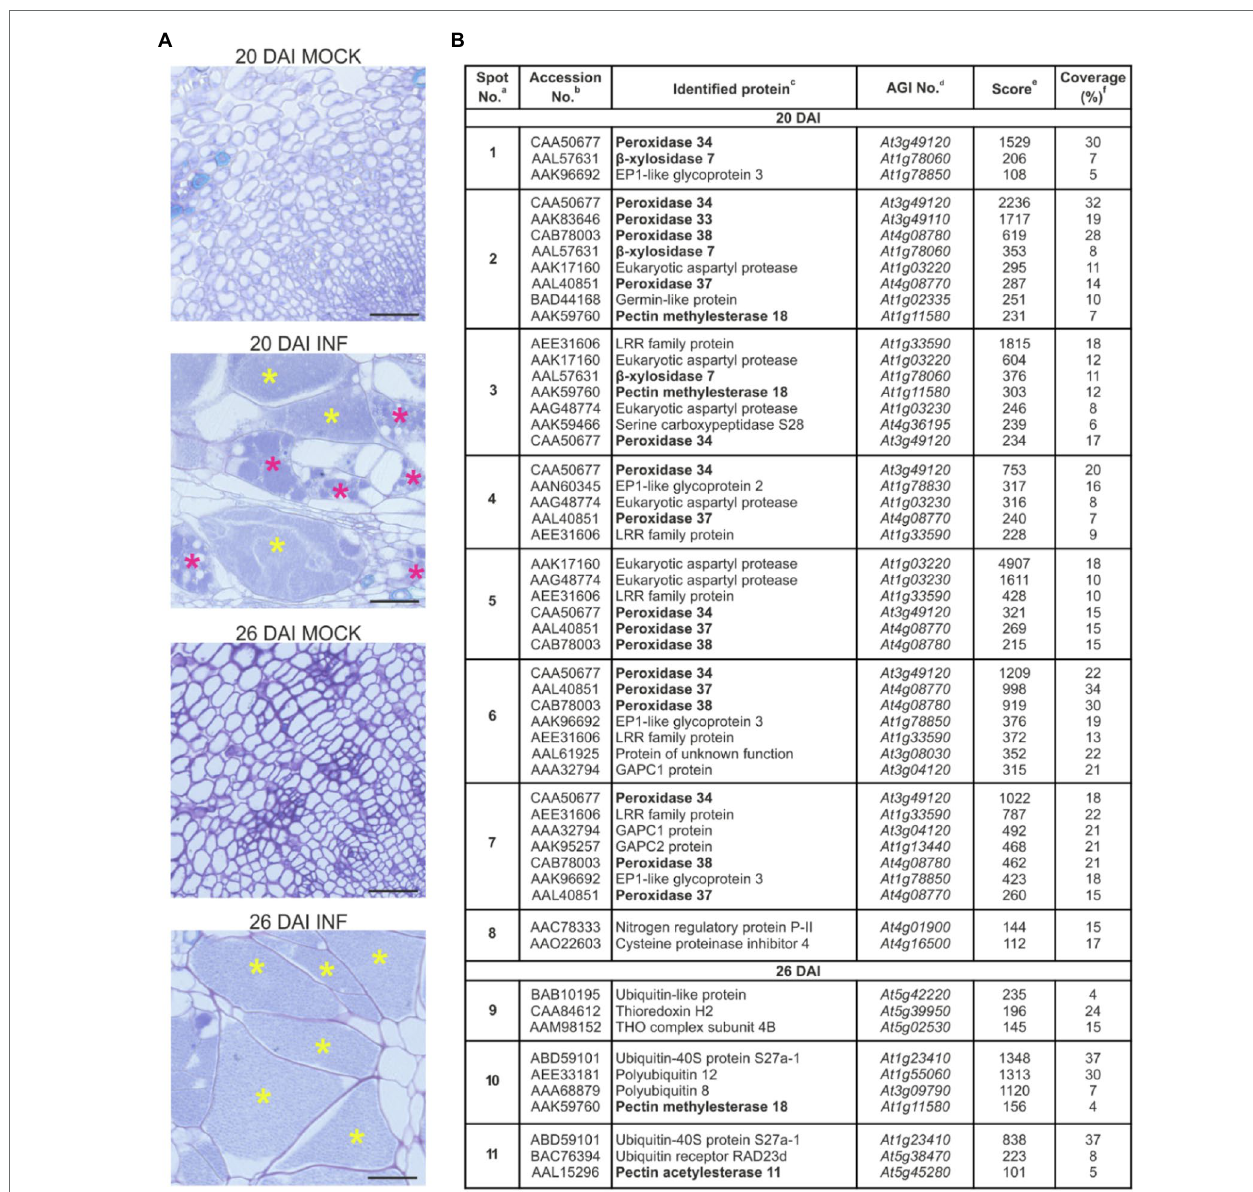
FIGURE 1 | Proteomic analysis of the cell wall samples of Col-0 hypocotyls after infection with Plasmodiophora brassicae. (A) Toluidine blue-stained transverse 5 μ m sections across hypocotyls of Col-0 plants before (mock) and after infection with P. brassicae , showing giant cell formation 20 DAI and 26 DAI. Scale bars represent 50 μ m. Asterisks indicate enlarged cells filled with resting spores (yellow) or secondary plasmodia (magenta). (B) List of identified proteins (P-BLAST matching) together with images of differential protein spots (present only in samples isolated from infected plants) 20 DAI (spots marked 1–8) and 26 DAI (spots marked 9–11). Complete raw 2-D protein maps are shown in Supplementary Figure S1 . Identified proteins potentially involved in cell wall remodeling are in bold. a Spot numbering is the same as in panel (B) . b Database accession (according to NCBInr) of a homologous protein. c Homologous protein in